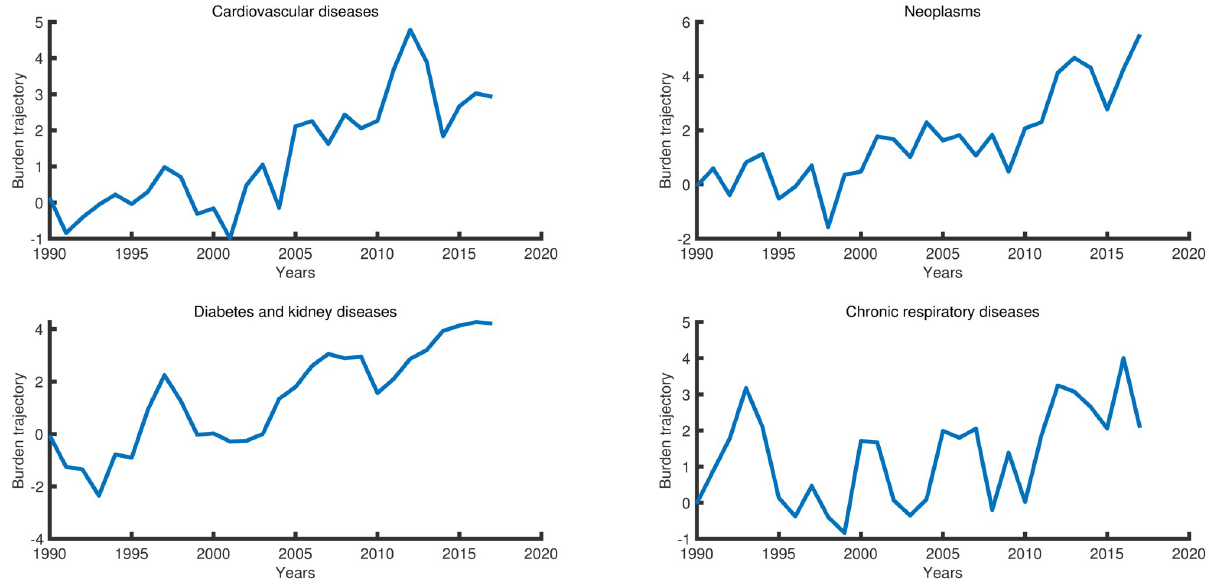
Fig 3. Particle Independent Metropolis-Hastings estimated trajectories for the four NCDs group of